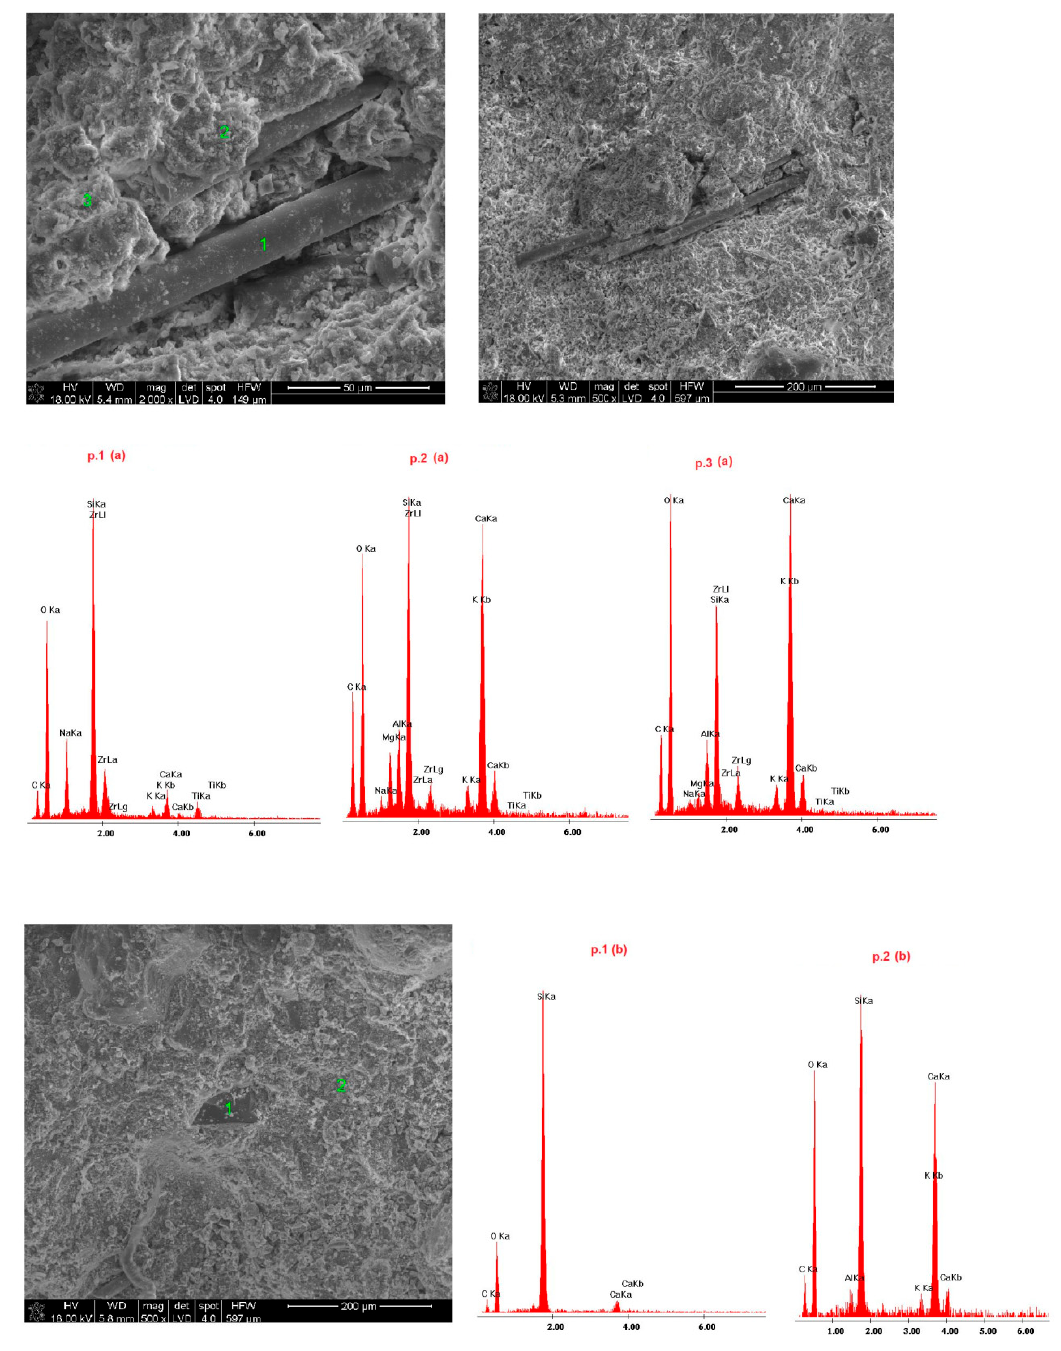
Figure 9. SEM microphotograph and energy dispersive spectroscopy (EDS) analysis of sample 1.